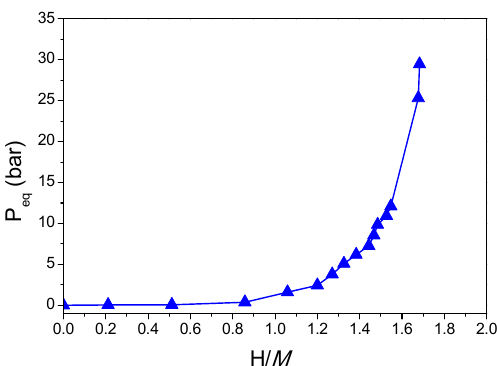
Figure 3. Pressure–composition isotherm for hydrogen absorption in Ti 0.325 V 0.275 Zr 0.125 Nb 0.275 (BM) at 250 °C.